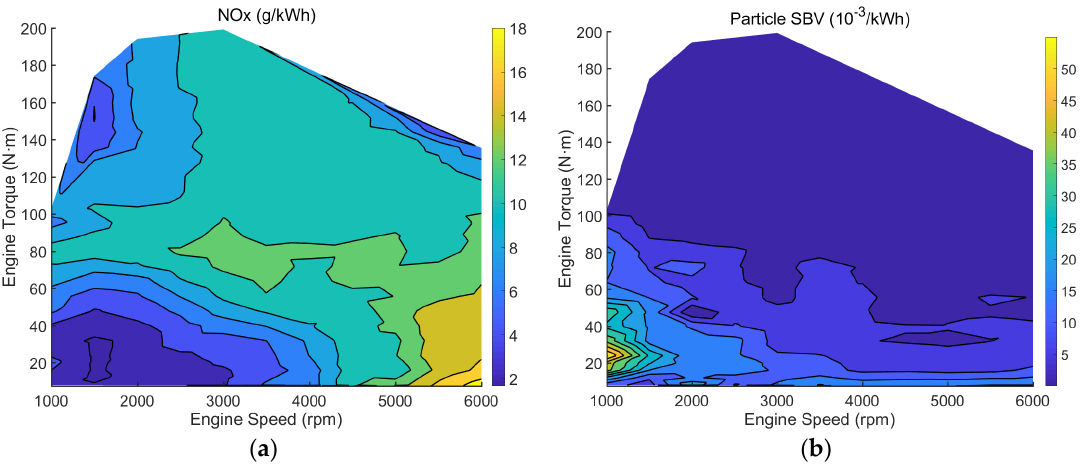
Figure 4. Emissions map of two main pollutants: ( a ) NOx and ( b ) Particle.